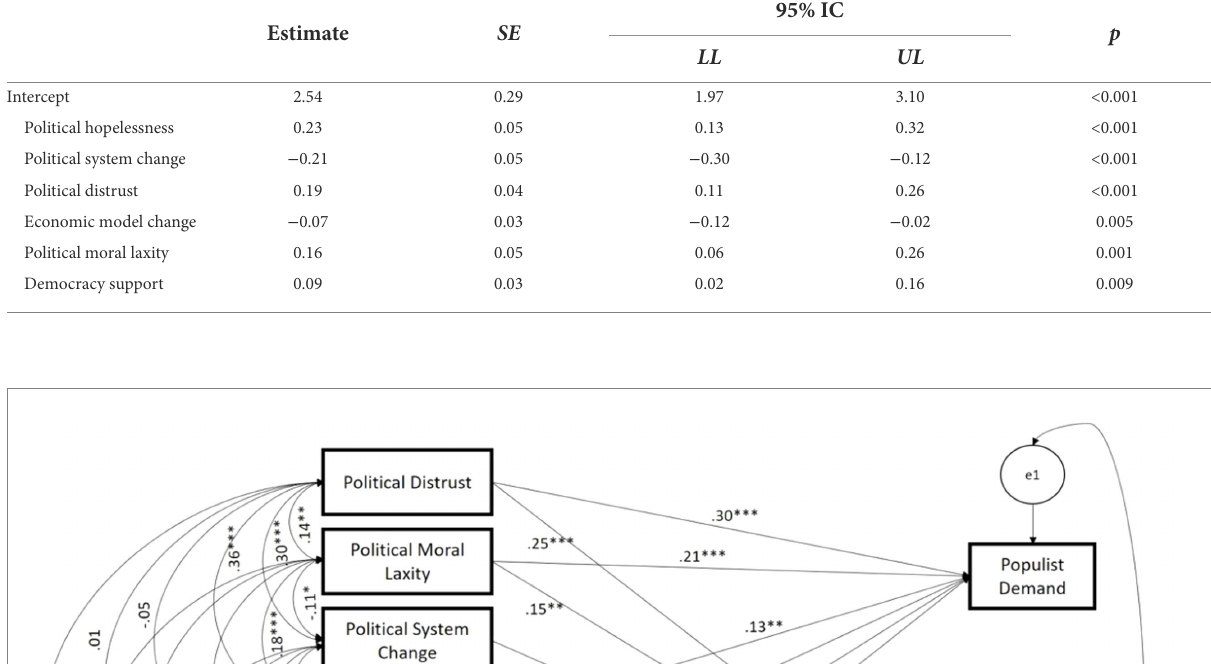
TABLE 4 Multiple linear regression of political cynicism, attitudes toward democracy and socio-political characteristics (IV) on the perception populism offer dimension (DV).